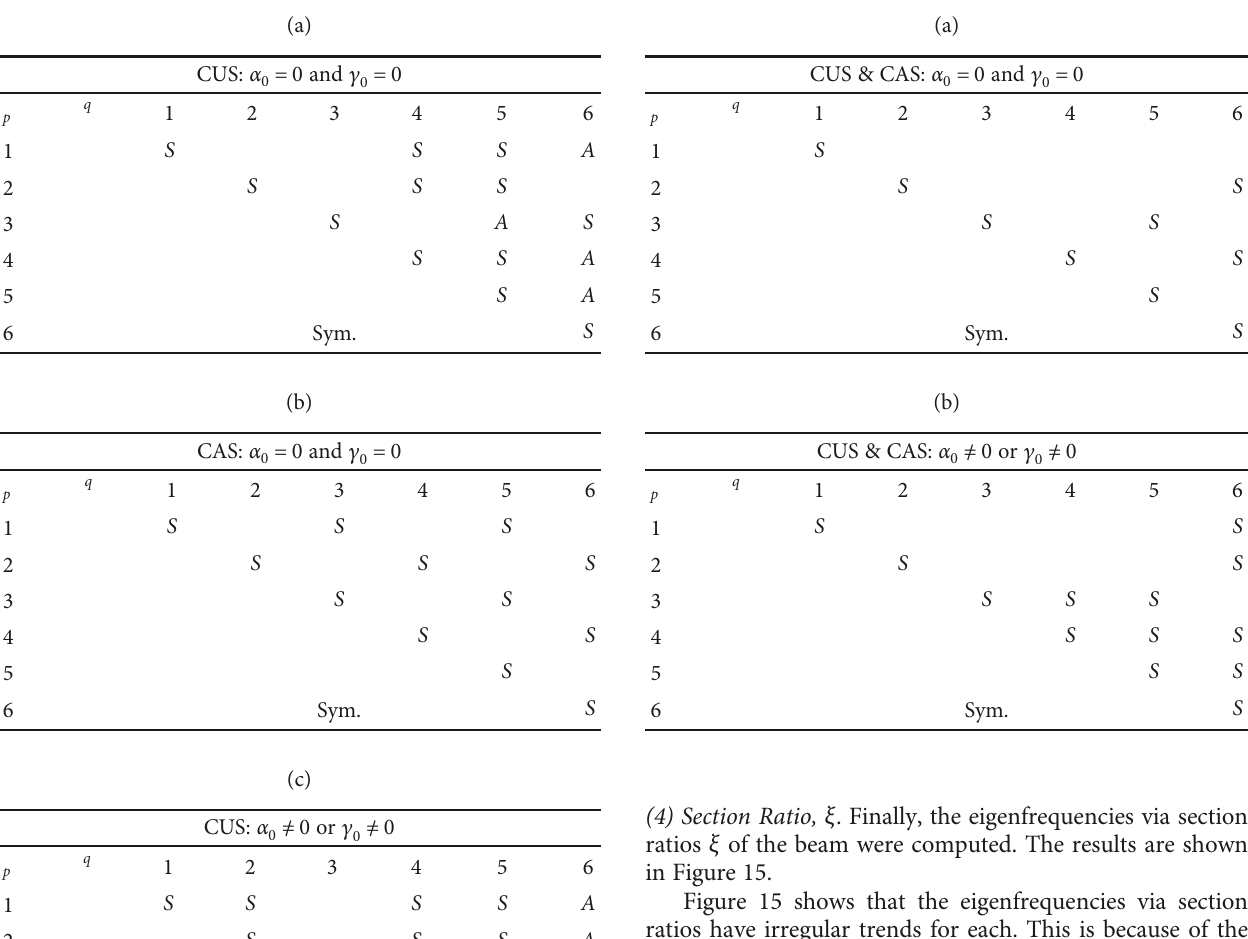
Table 6: Mass matrix M pq of Model A and Model C.